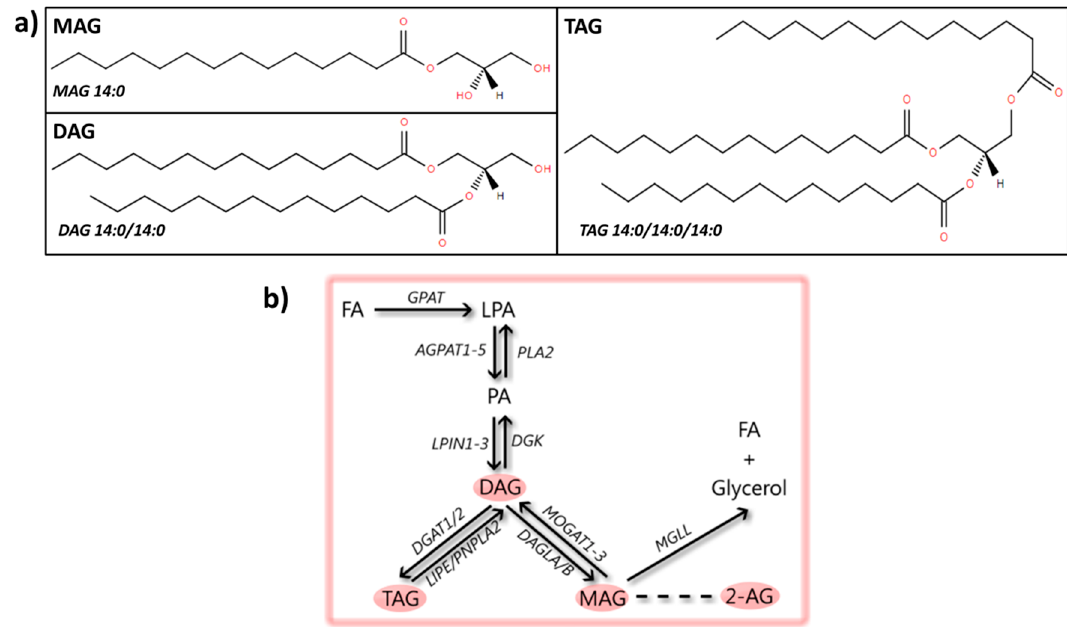
Figure 3. Glycerolipids: structures and metabolic steps involved. ( a ) Schematic representation of the chemical structures of glycerolipids, including monoacylglycerol (MAG 14:0), diacylglycerol (DAG 14:0/14:0), and triacylglycerol (TAG 14:0/14:0/14:0). Chemical structures are adapted from the LIPID